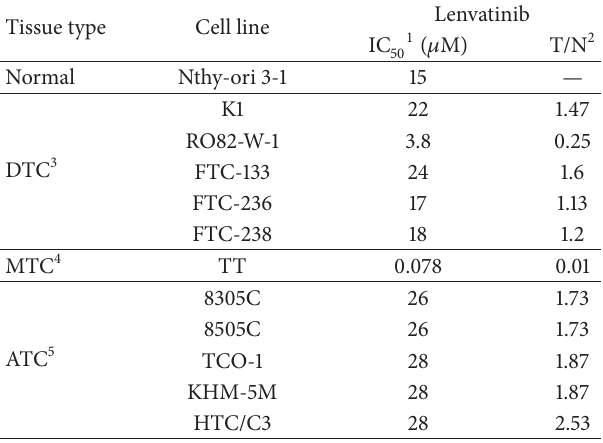
Table 1: In vitro antiproliferative activity of lenvatinib against human thyroid cancer